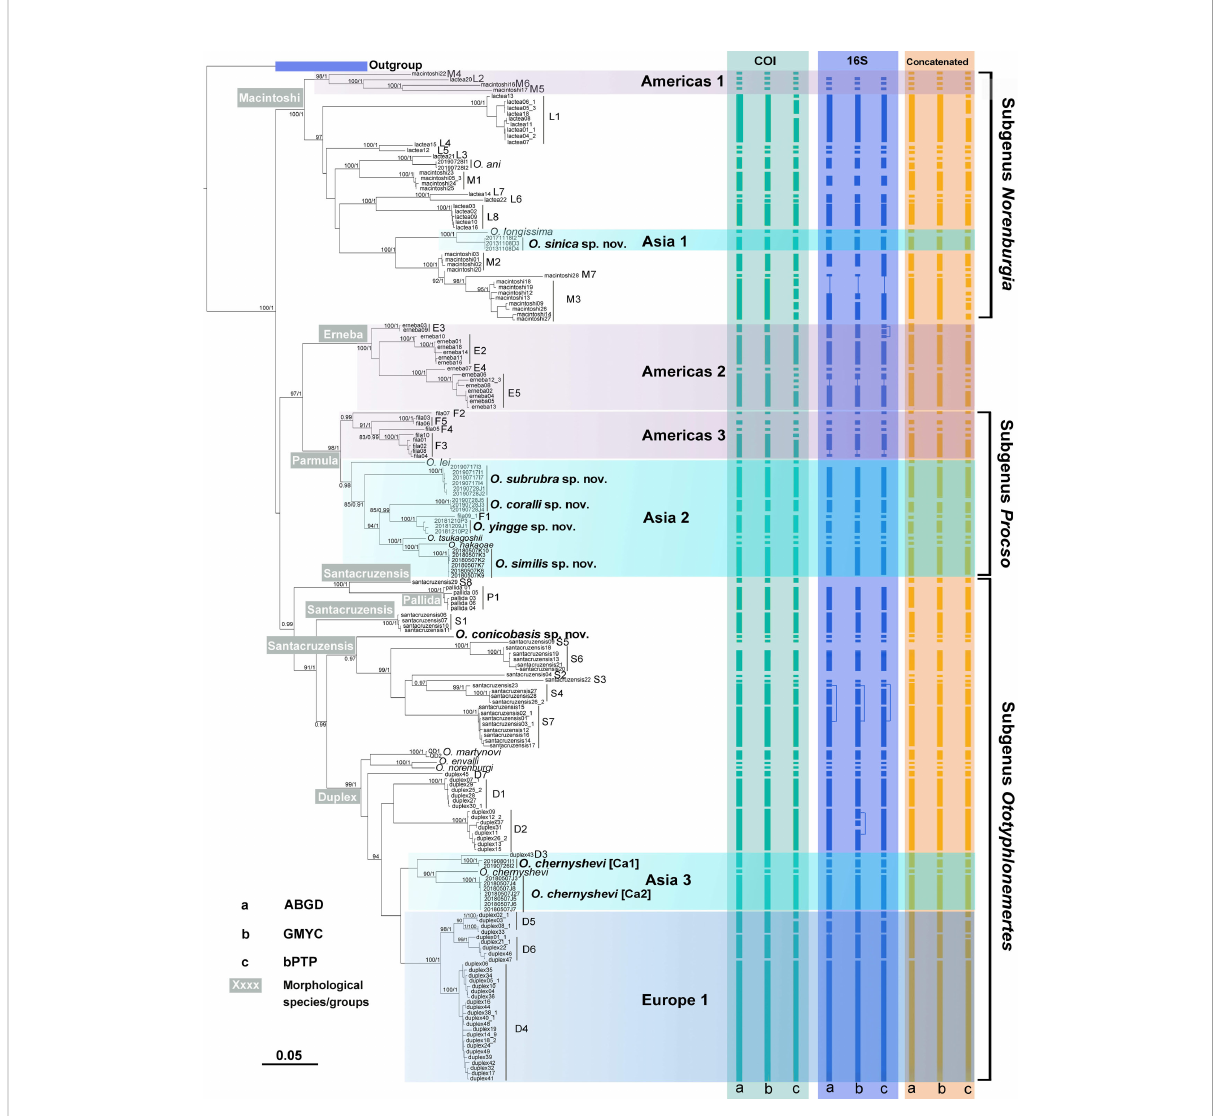
FIGURE 2 Phylogenetic tree and results of species delimitation analyses. The tree is reconstructed by RAxML analyses based on the concatenated dataset (COI, 16S, 18S and 28S). The Bayesian inference analysis yields almost identical tree topology (see Figure S1). Bootstrap support values >80 of the RAxML analysis (1000 bootstrap replicates) and Bayesian posterior probabilities >0.80 are provided as numbers next to nodes. Results of three species-delimitation analyses, ABGD, GMYC, bPTP, are indicated by the columns of vertical bars for each